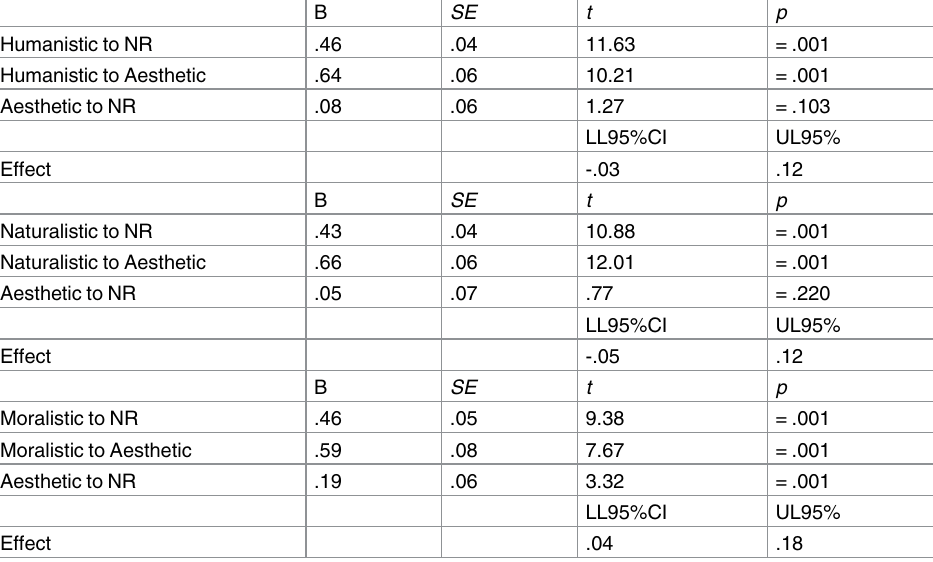
Table 15. Simple mediation of the indirect effectsof valuing humanistic, naturalistic and moralistic indicators on nature relatedness (n = 118; 5000 bootstrap samples). B SE t p Humanistic to NR .46 .04 11.63 = .001 Humanistic to Aesthetic .64 .06 10.21 = .001 Aesthetic to NR .08 .06 1.27 = .103 LL95%CI UL95% Effect -.03 .12 B SE t p Naturalistic to NR .43 .04 10.88 = .001 Naturalistic to Aesthetic .66 .06 12.01 Aesthetic to NR .05 .07 .77 LL95%CI UL95% Effect -.05 .12 SE Moralistic to NR .46 Moralistic to Aesthetic .59 .08